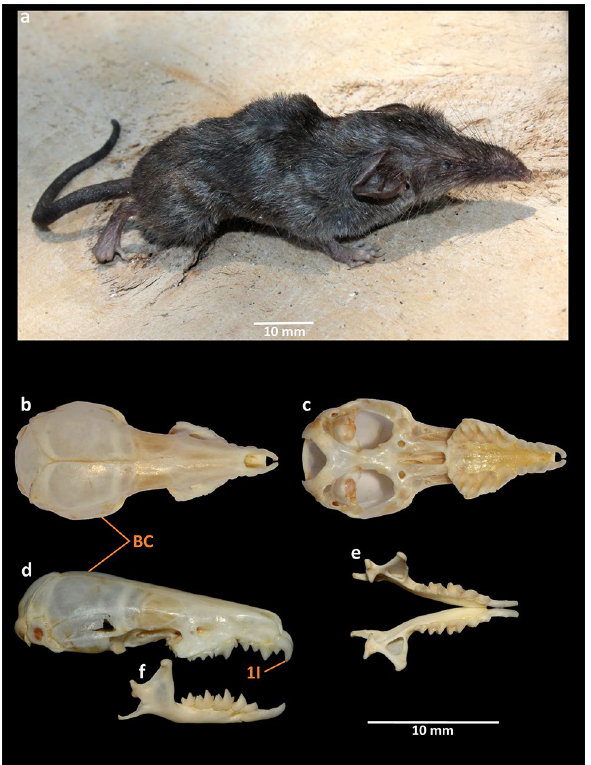
Figure 1. Crocidura narcondamica sp. nov. (holotype ZSI-29313, female). ( a ) Dorso-lateral view of female (adult alive). Views of the cranium ( b ) dorsal, ( c ) ventral, and ( d ) lateral. Views of the mandible ( e ) lateral